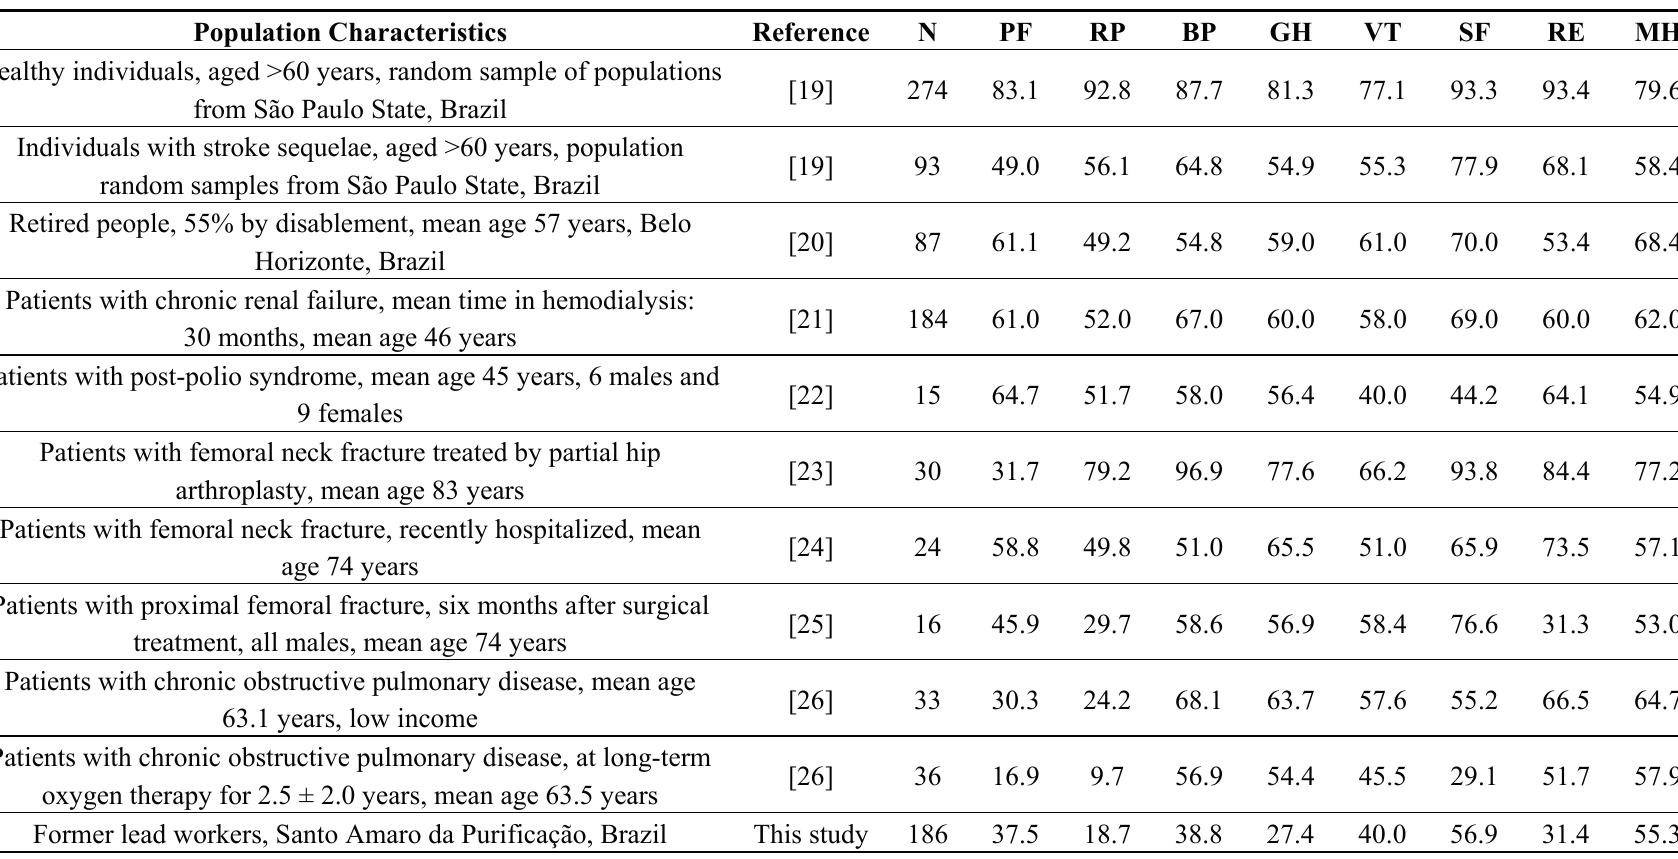
Table 2. SF-36 dimensions raw scores (mean) in Brazilian populations and in former lead workers from the Santo Amaro da Purificação lead smelter, Brazil,